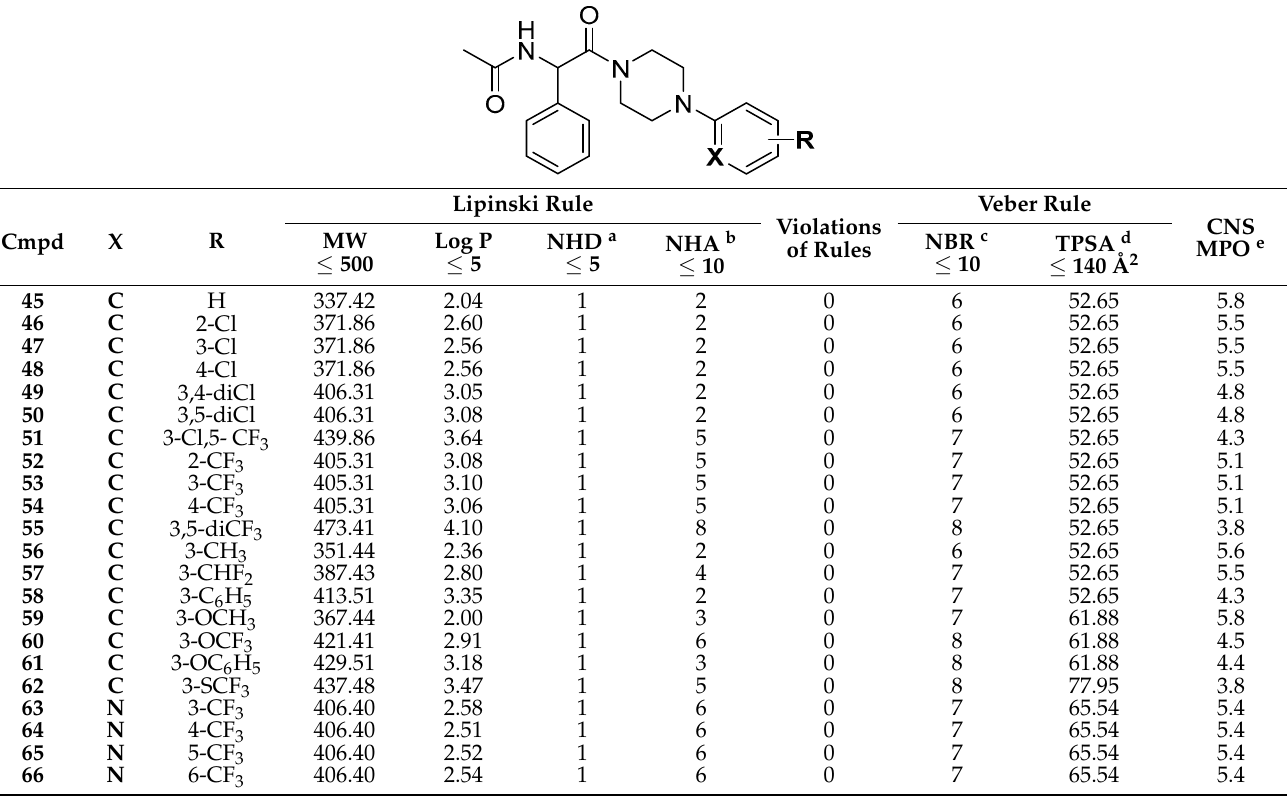
Table 1. Drug-like parameters according to Lipinski rule, Veber rule, and CNS MPO.